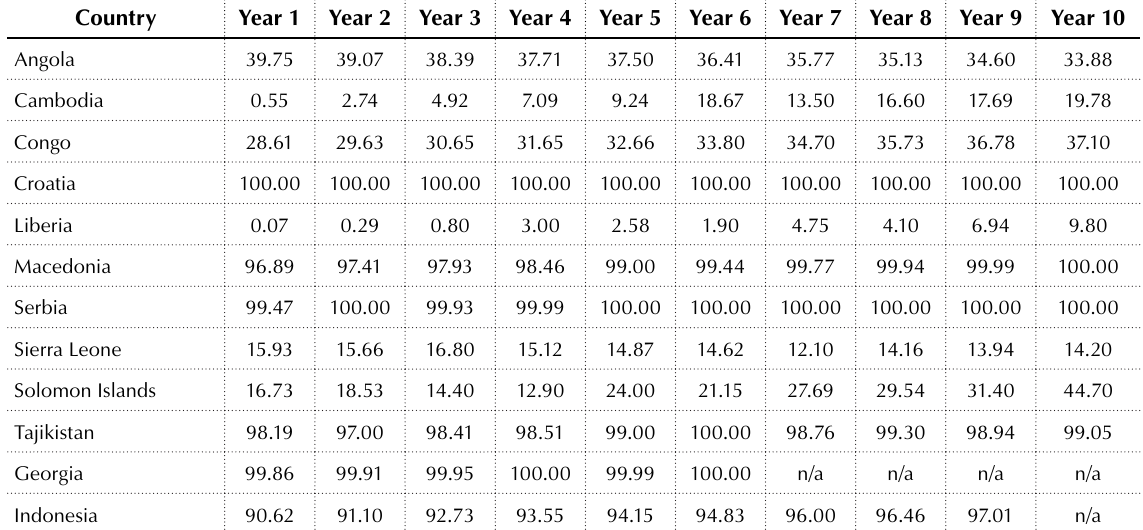
Source: The World Bank Group database.